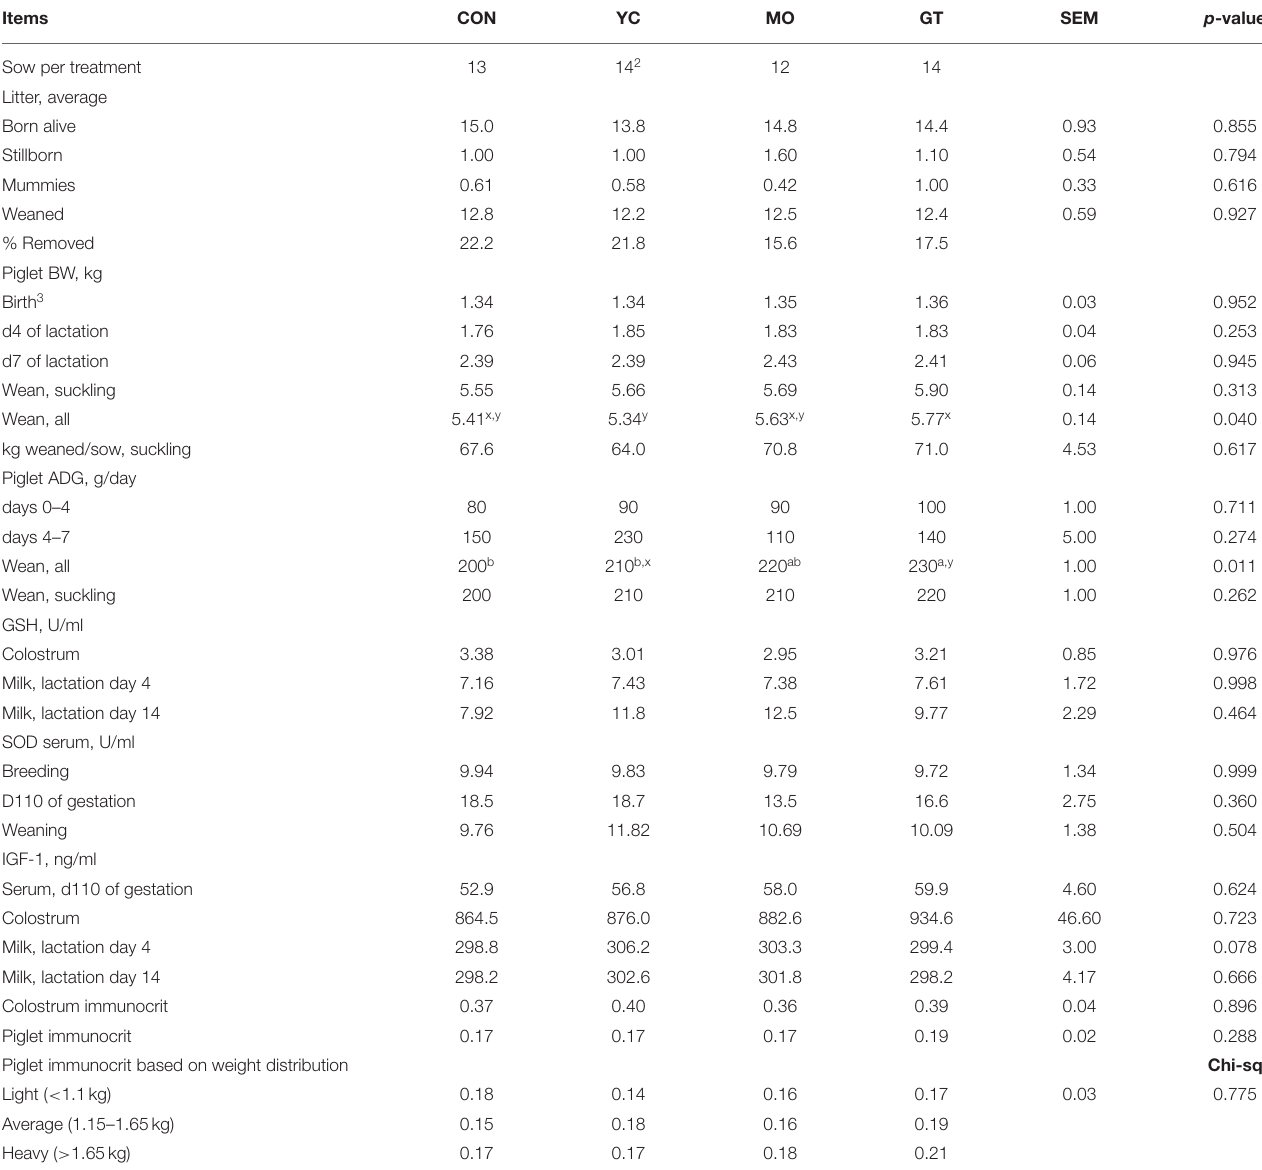
TABLE 6 | Reproductive performance of sows fed one of four treatments throughout gestation and lactation, litter performance in the suckling phase, sow antioxidant status, and immunological profile of piglets and sow milk (study 2 1 ) 4,5